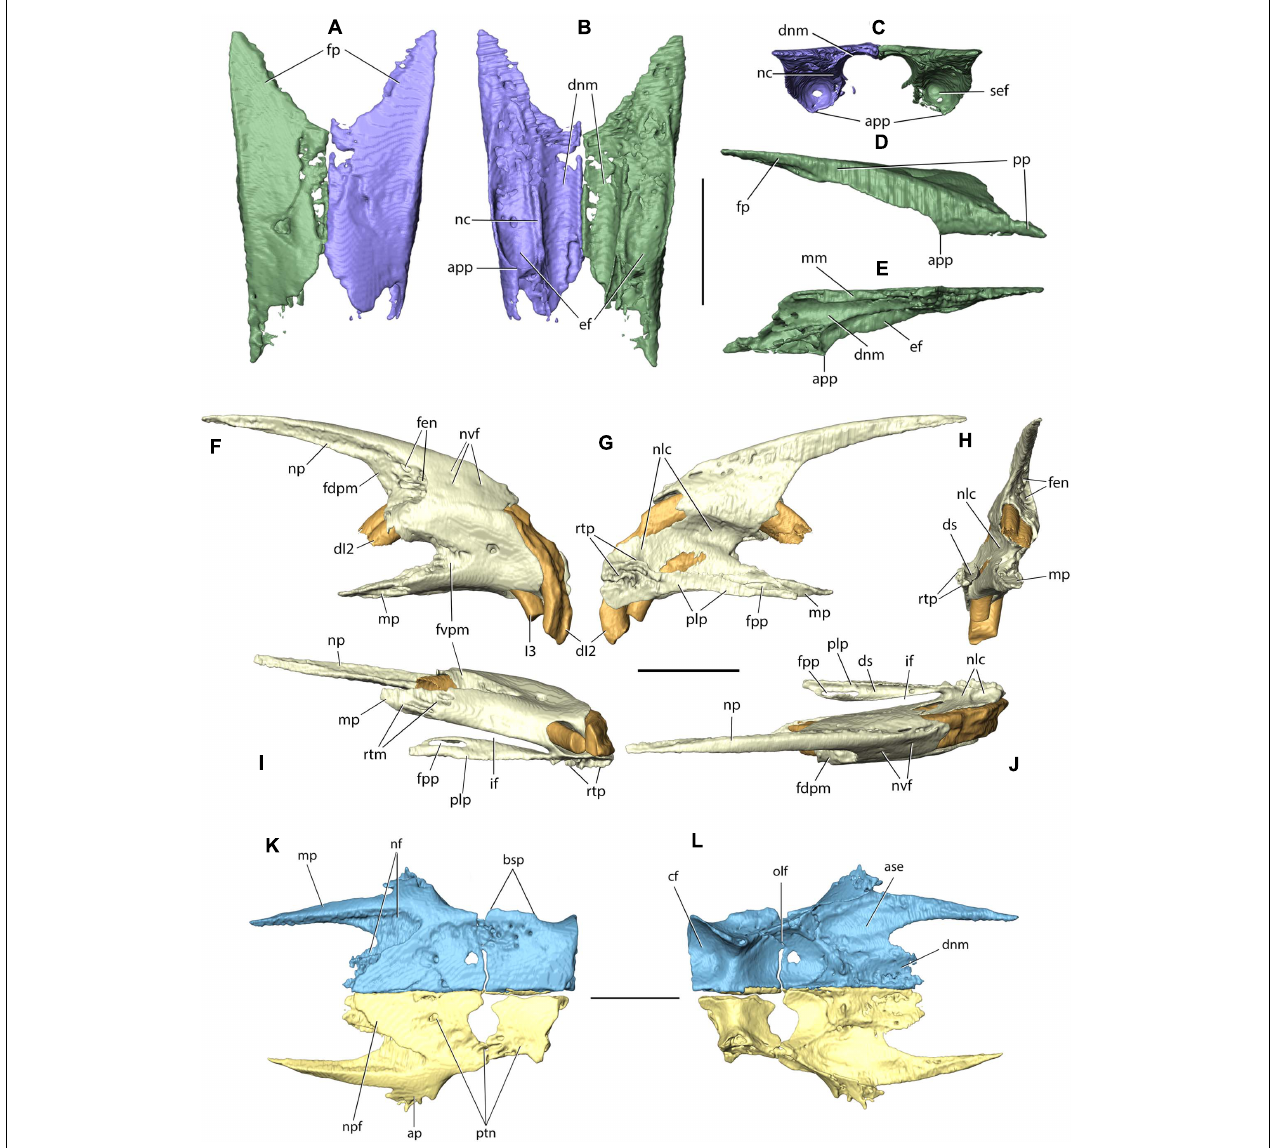
FIGURE 4 | Nasal, premaxilla (incisive), and frontal of Palaeolagus haydeni (FMNH PM9476). Posterior portions of the left (purple) and right (green) nasals in (A) dorsal, (B) ventral, and (C) posterior views. Right nasal in (D) lateral and (E) medial views. Right premaxilla in (F) lateral, (G) medial, (H) posterior, (I) ventral, and (J) dorsal views. Left (yellow) and right (blue) frontals in (K) dorsal and (L) ventral views (orbital portions removed). ap, anterior prong; app, apex of premaxillary process; ase, articular surface for ethmoid; bsp, base of supraorbital process (broken); cf, cerebral fossa; dnm, dorsal nasal meatus; ds, dorsal sulcus; ef, ethmoidal fossa; fdpm, facet for dorsal prong of maxilla; fen, fenestration; fp, frontal process; fpp, foramen in palatine process; fvpm, facet for ventral prong of maxilla; dI2, anterior upper incisor; I3, posterior upper incisor; if, incisive foramen; mm, medial margin; mp, maxillary process; nc, nasoturbinate (ethmoidal) crest; nf, nasal facet; nlc, nasolacrimal canal; np, nasal process of premaxilla; npf, nasal process of frontal; nvf, neurovascular foramen; olf, olfactory bulb fossa; plp, palatine process; pp, premaxillary process; ptn, pitting; rtm, ridges and troughs for maxilla; rtp, ridges and throughs for contralateral premaxilla; sef, anterior septum of ethmoidal fossa. Scale bars = 5